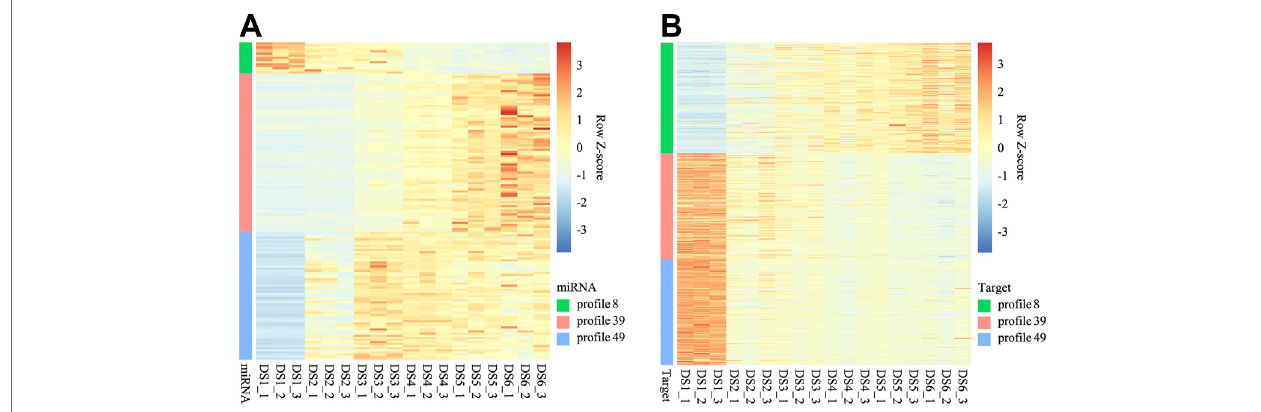
FIGURE 6 | Heat maps for expression of miRNAs (A) of three co-expression pro fi les and their targets (B) .